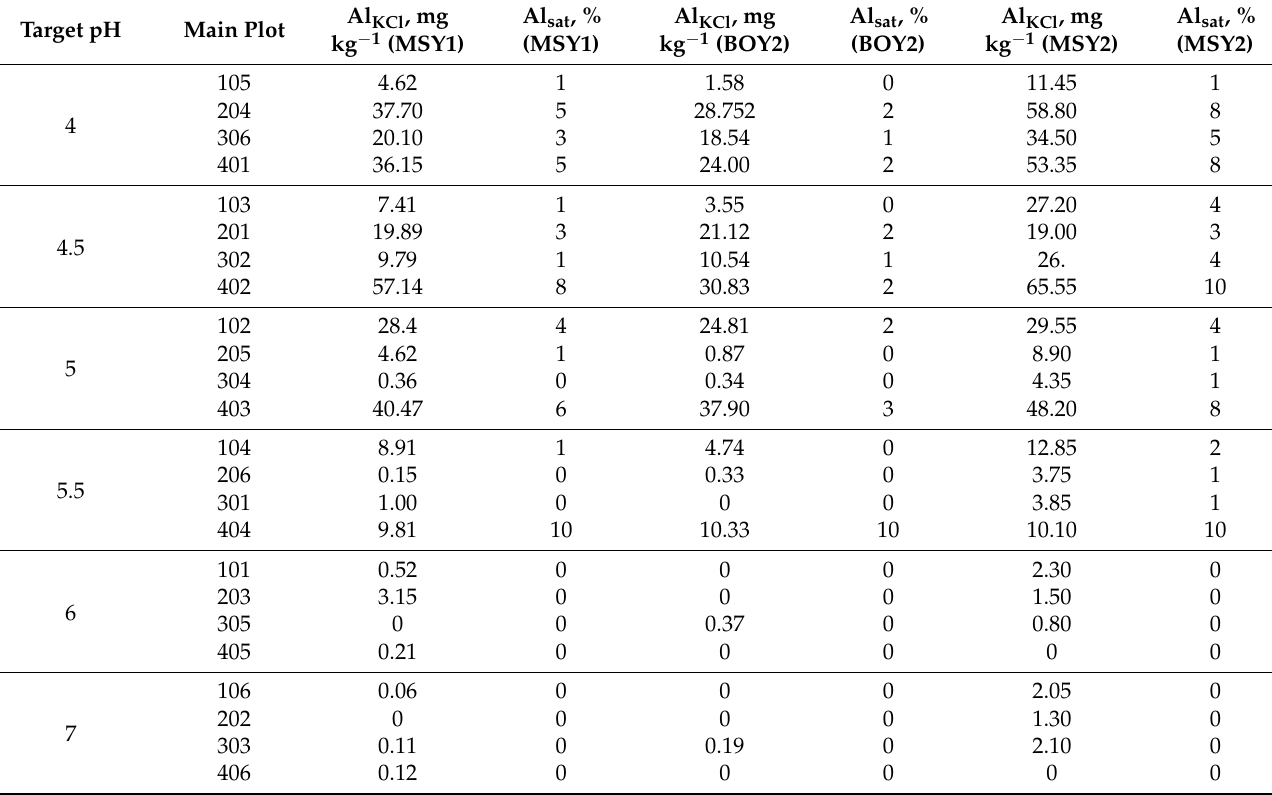
Table 4. Continuous monitoring for 2 winter wheat cropping seasons regarding exchangeable Al (Al KCl ) and Al saturation (Al sat ) for each main plot at Chickasha.